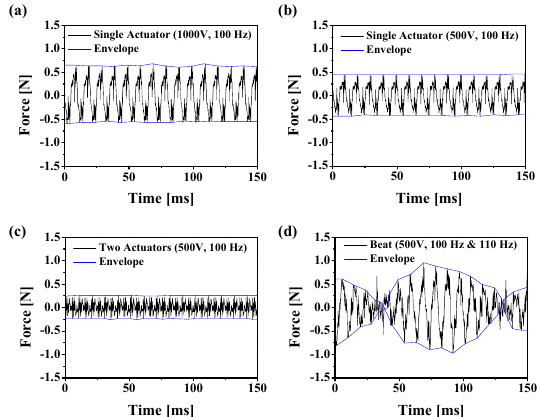
Figure 8. Results of the measured accelerations under four conditions; ( a ) 1000 V pp (100 Hz) + 0 V, ( b ) 500 V pp (100 Hz) + 0 V, ( c ) 500 V pp (100 Hz) + 500 V pp (100 Hz), and ( d ) 500 V pp (100 Hz) + 500 V pp (110 Hz).